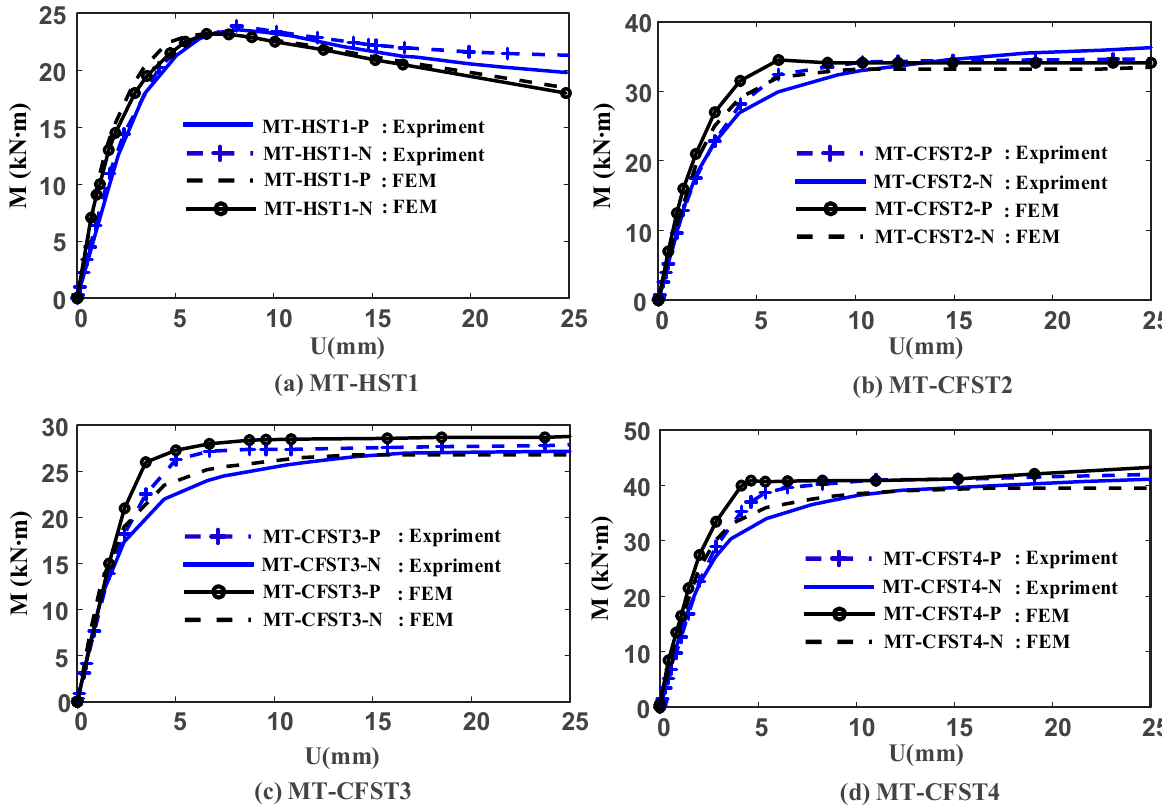
Figure 13. Comparison of numerical results with test results: ( a ) MT-HST1; ( b ) MT-CFST2; ( c ) MT-CFST3; ( d ) MT-CFST4.